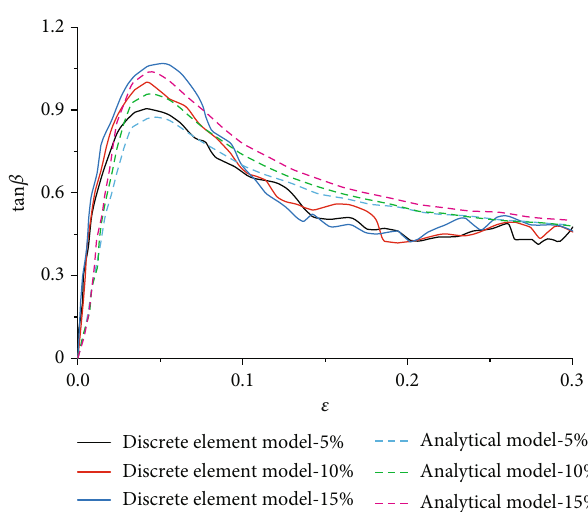
Figure 3: Fitting curves of the tan β - ε relationship between the analytical model and the discrete element model under di ff erent